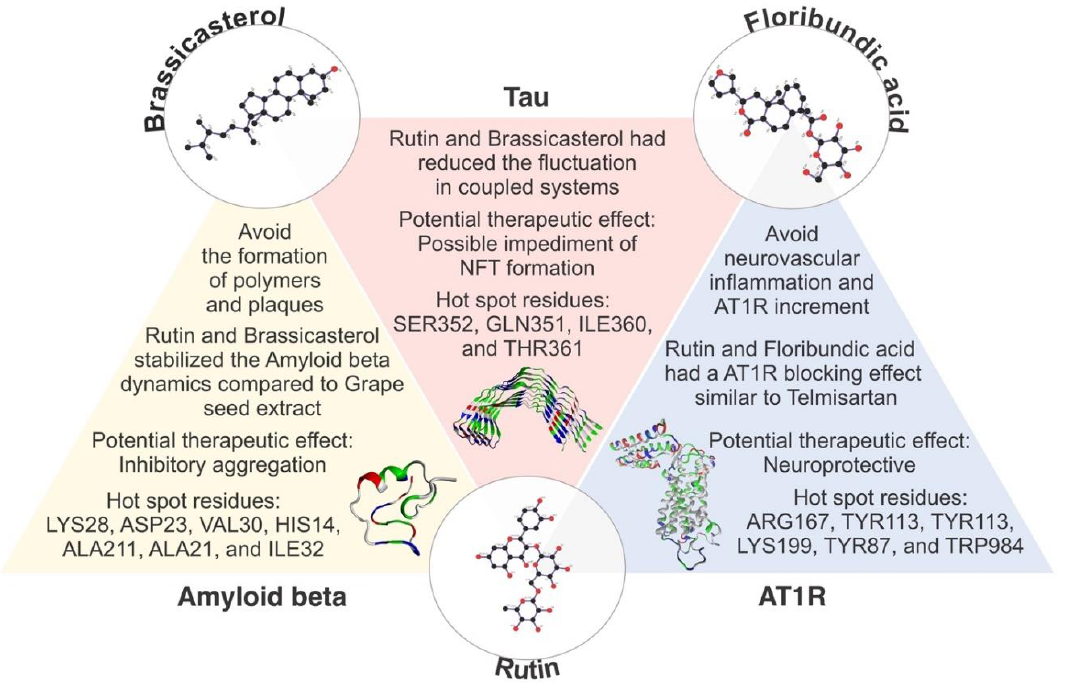
Figure 6. Diagram illustrating the polypharmacological activity of the metabolites rutin, brassicasterol, and floribundic acid on tau, amyloid beta, and AT1R, AD pathologic markers. Surprisingly, the molecules considered as controls, such as grapeseed extract, nicotinamide, and telmisartan for the receptors amyloid beta, tau protein, and AT1R, respectively, were not the best options with the highest binding energy [88,89].